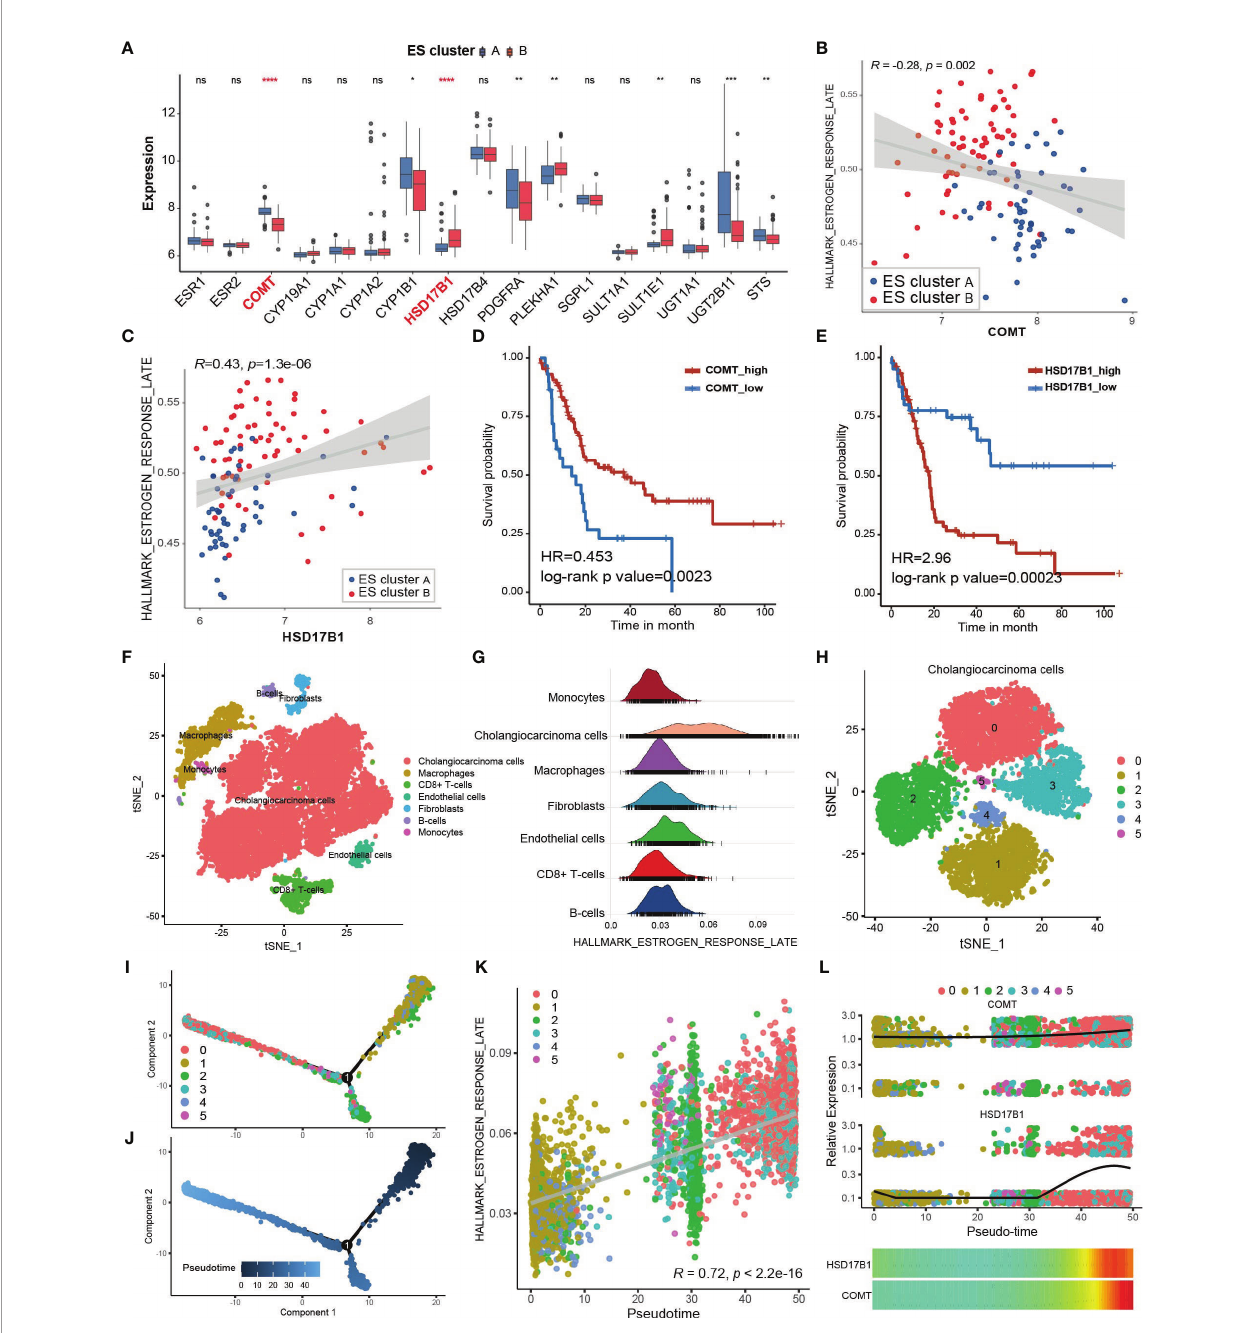
FIGURE 3 | Potential cause and spatiotemporal speci fi city of the differential estrogen response. (A) Differential expression of estrogen receptors and estrogen metabolism-related genes. The top and bottom of the boxes represent the interquartile range of the values. The thick lines in the middle of the boxes represent the median values. The black dots show the outliers. The signi fi cant differences among different ECM clusters were evaluated using Student ’ s t test. (B, C) Scatter plot depicting the correlation between the GSVA score of “ Estrogen response late ” and the expression of COMT (Spearman correlation test, R = -0.28, p value =0.002) or HSD17B1 (Spearman correlation test, R = 0.43, p value =1.3×10 -6 ). The color of the dots represents the ES clusters annotated by the legend. (D, E) Kaplan – Meier curves for overall survival of the patients with low or high expression of COMT or HSD17B1 in the GSE89749 cohort. (F) Single cell clusters for tumor tissues from fi ve CCA samples. (G) Ridge plot showing the AUCell score of “ Estrogen response late ” in different cell types. (H) CCA cells were further divided into six subgroups exhibited by the TSNE plot. (I, J) Cell trajectory plot of cholangiocarcinoma cells annotated by subgroups of CCA cells and pseudotime. (K) Scatter plot showing the correlation between the AUCell score of “ Estrogen response late ” and the pseudotime of CCA cells. Spearman correlation test, r = 0.72, p <2.2×10 -16 . (L) The combined scatter plot and heatmap plot exhibiting the change in expression of COMT and HSD17B1 following pseudotime in CCA cells. Statistical p-value (*,P < 0.05; **,P < 0.01; ***,P < 0.001, ****,P < 0.0001). ns, not signi fi